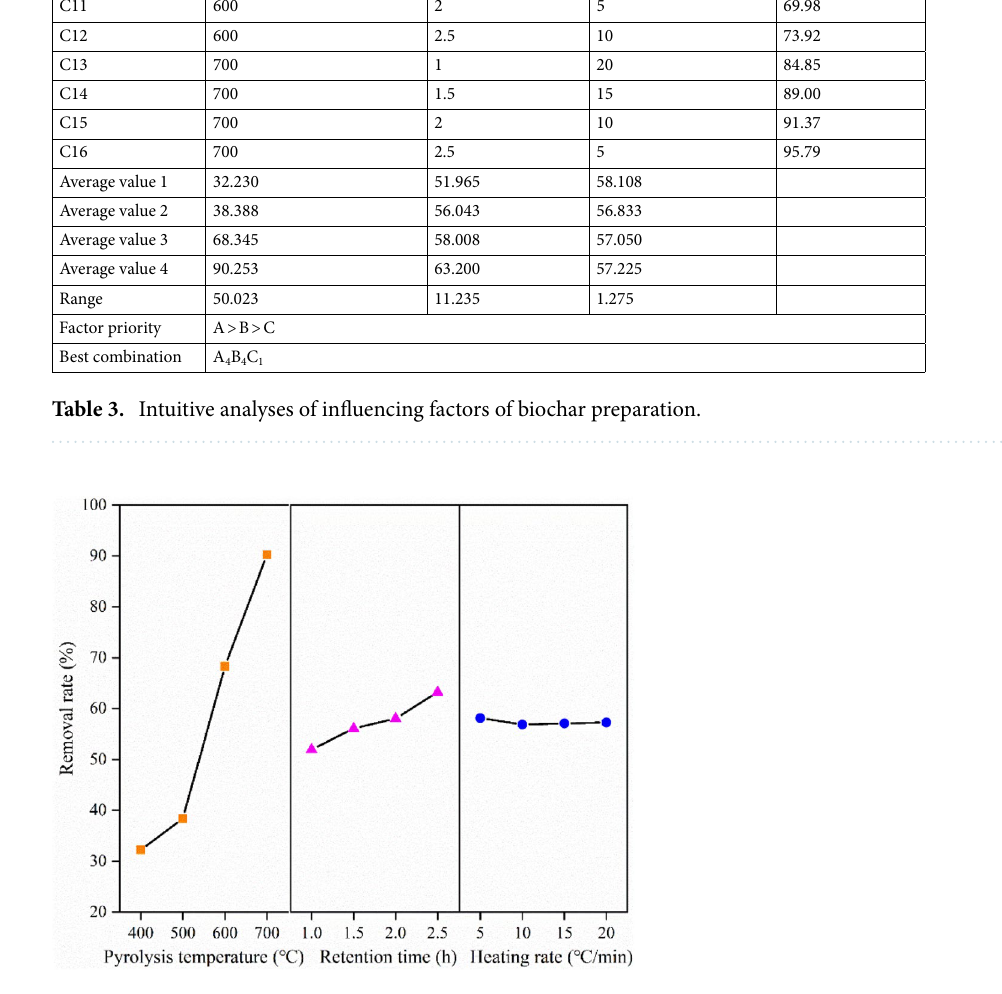
Figure 7. Intuitive analysis diagram of influencing factors for biochar preparation.